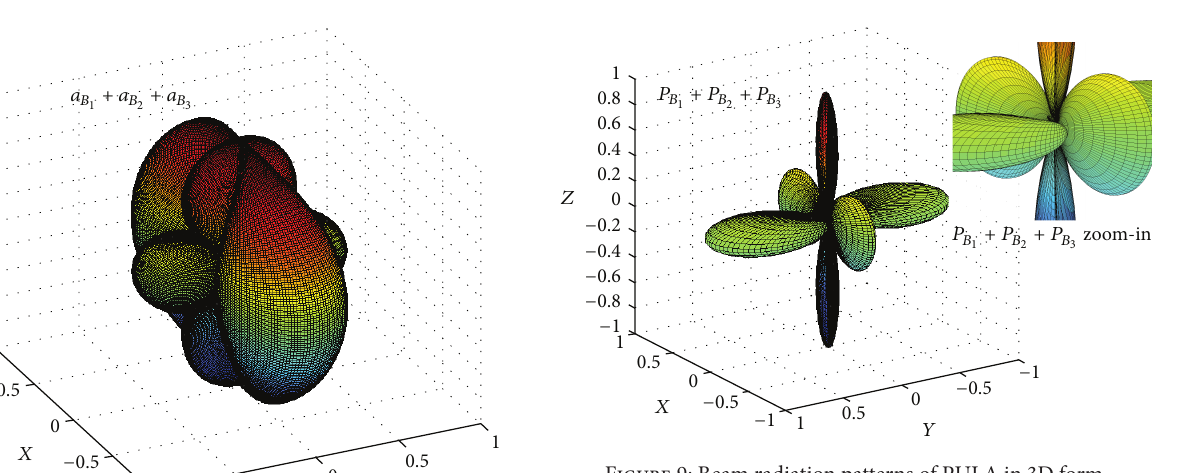
Figure 9: Beam radiation patterns of PULA in 3D